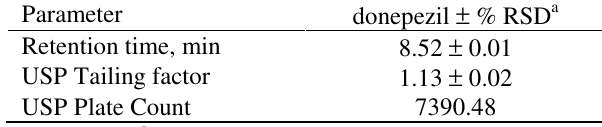
Table 4. System suitability parameters for donepezil hydrochloride by the proposed LC method